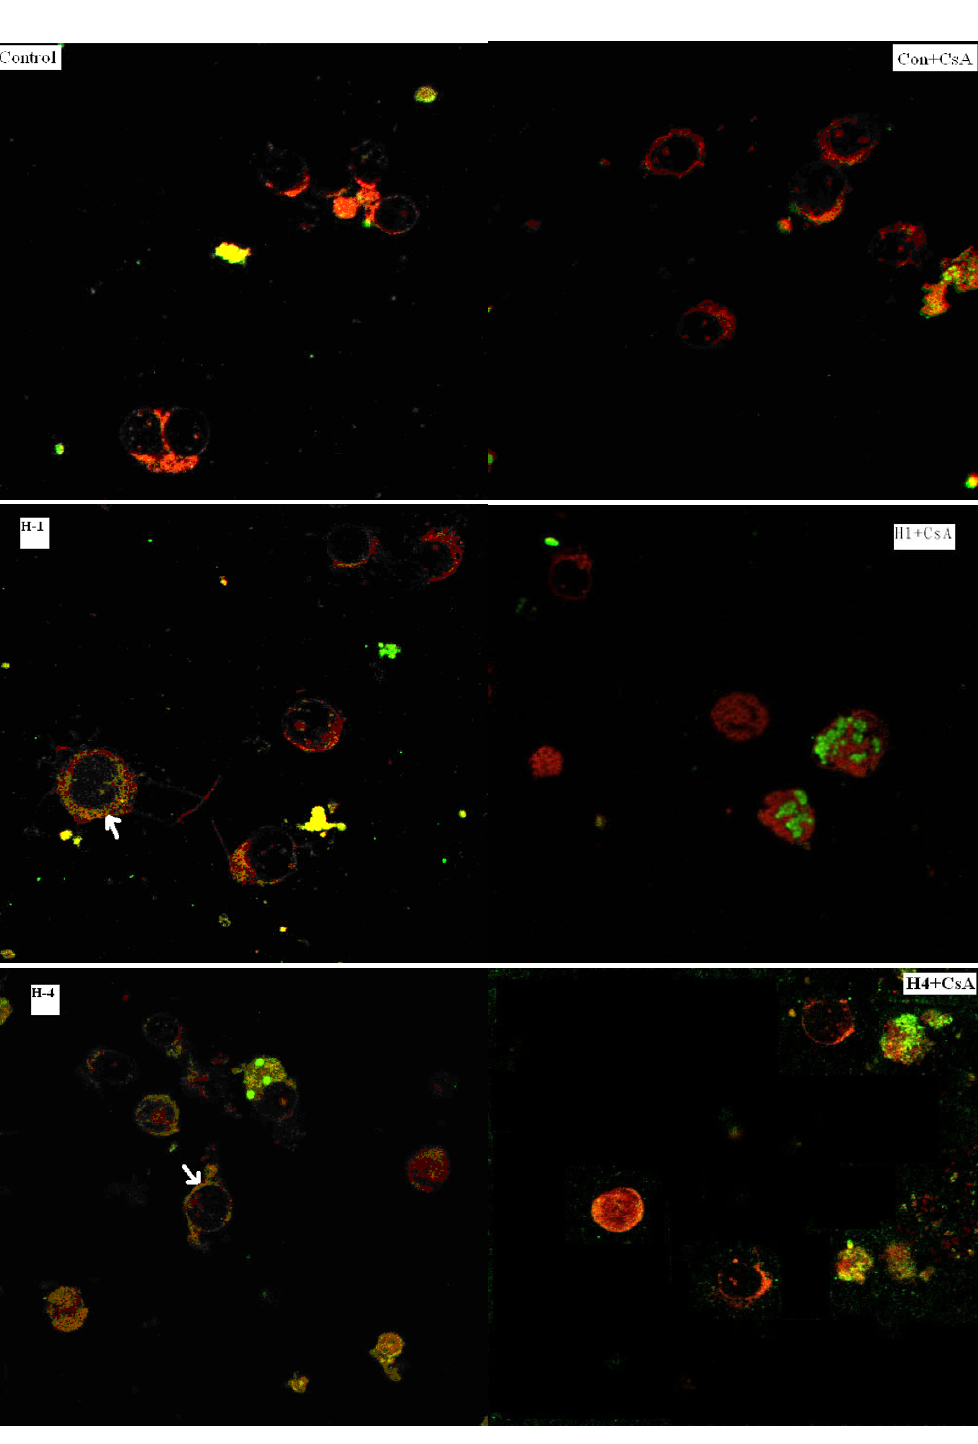
Figure 3 Localization of mitochondrial VDAC and Bax by confocal microscopy . Control, cell line from control group; Con+CsA, cell line incubated with CsA (2 μ M) for 30 min; H-1, cell line from III-14; H-1+CsA, cell line incubated with CsA (2 μ M) for 30 min; H-4, cell line from III-19; H-4+CsA, cell line incubated with CsA (2 μ M) for 30 min. VDAC was stained with FITC-green (green fluorescence); Bax was stained with rhodamine 123 (red